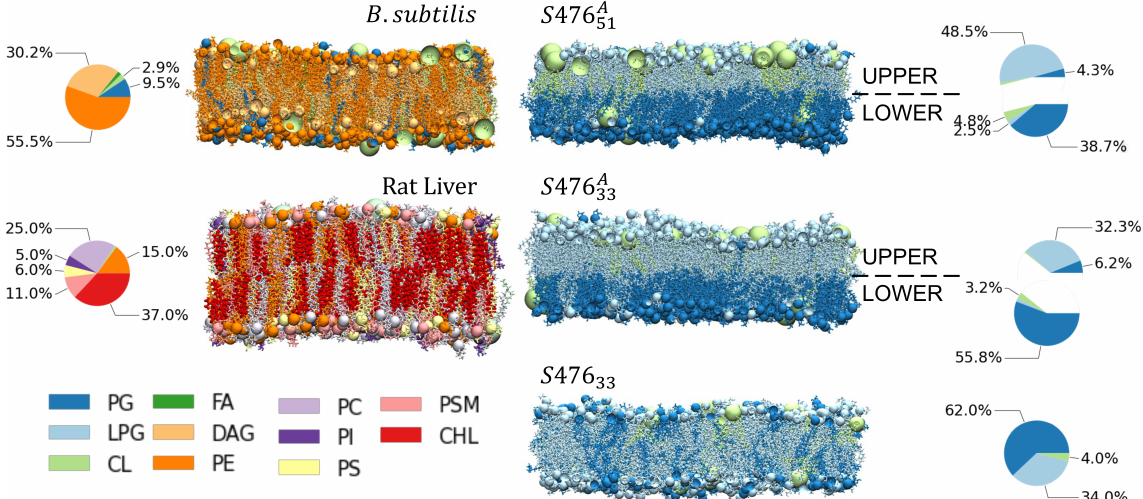
Figure 1. Systems and Nomenclature Summary. Composition and distribution of five types of plasma membranes modeled in this work: one for B. Subtilis , one for rat liver cell, and three for S. aureus ( S 476) membranes. S. aureus membrane are labeled according to symmetry (A for asymmetric) and percent concentration of LPG (33% or 51%). Only composition fractions greater than 2% are shown here. Only non-sterol containing membranes are shown. All abbreviations are listed at the end of the